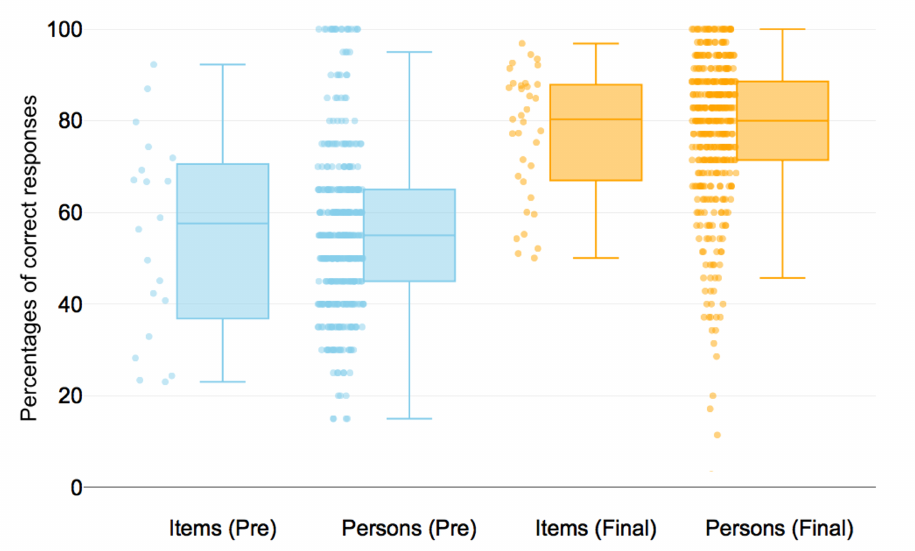
Figure 4. Percentages of correct responses to items and persons in the pre- and